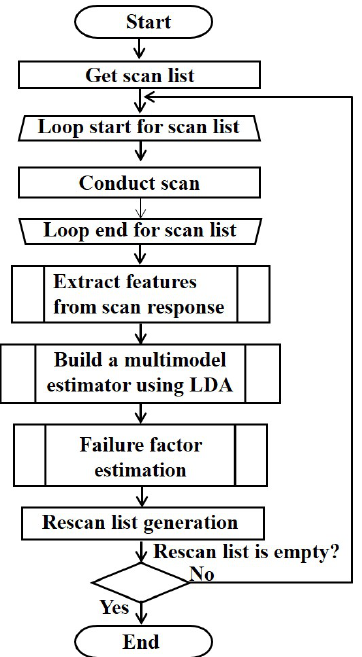
Figure 1. Overall flowchart of scan failure/delay cause